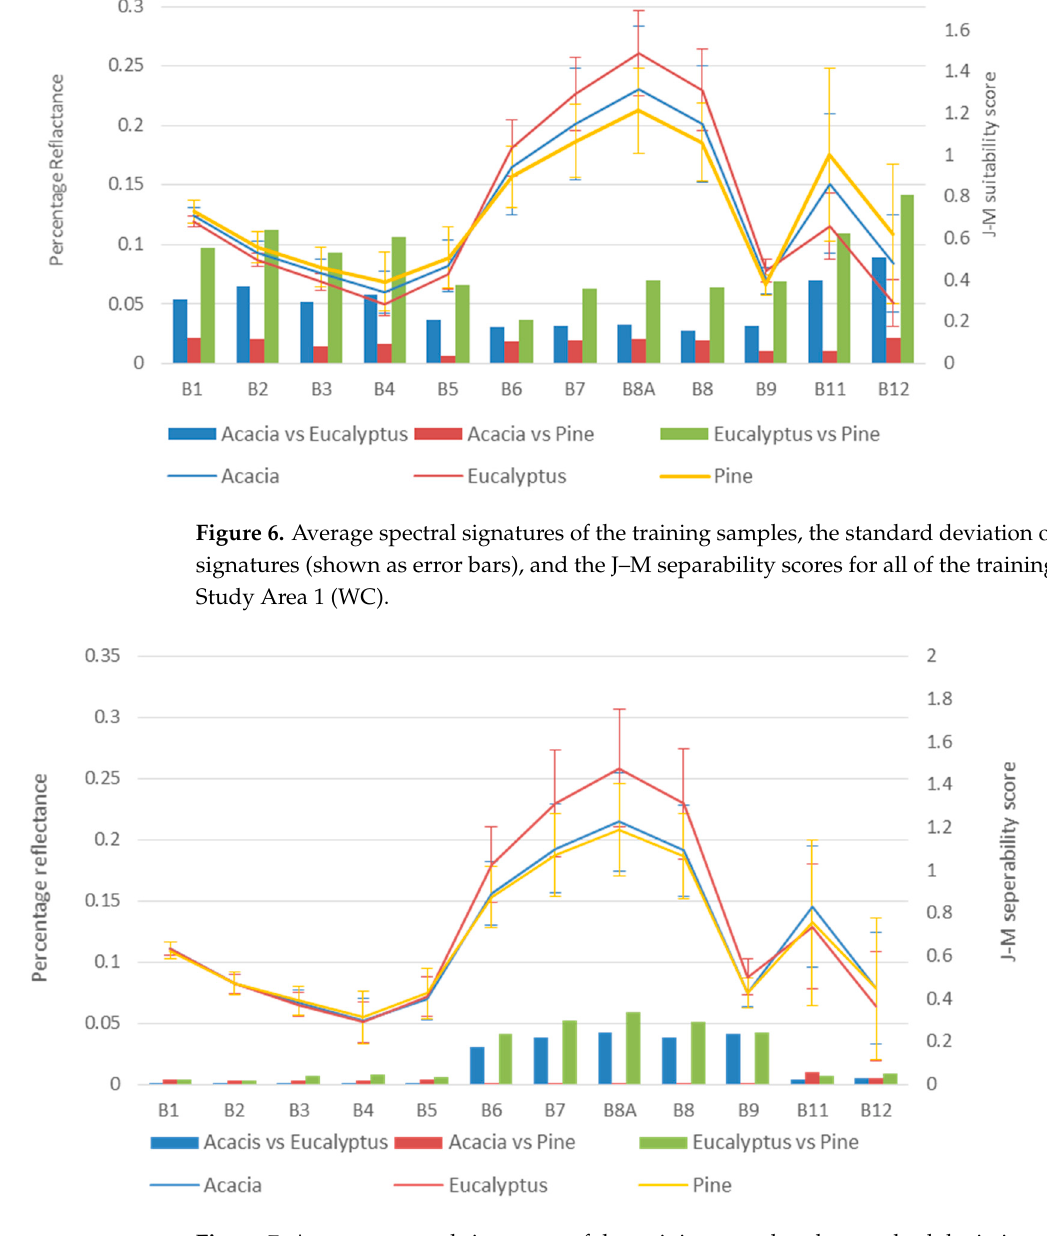
Figure 7. Average spectral signatures of the training samples, the standard deviation of the spectral signatures (shown as error bars), and the J–M separability scores for all of the training samples for Study Area 2 (KZN).